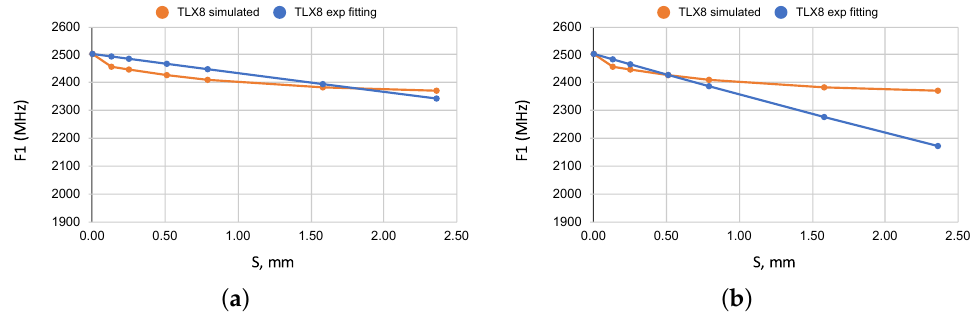
Figure 3. Attempts of exponential fitting of one set of the reference data. ( a ) TLX8: fitting with α = 0.028 (better fitting for the last part of the curve). ( b ) TLX8: fitting with α = 0.06 (better fitting for the first part of the